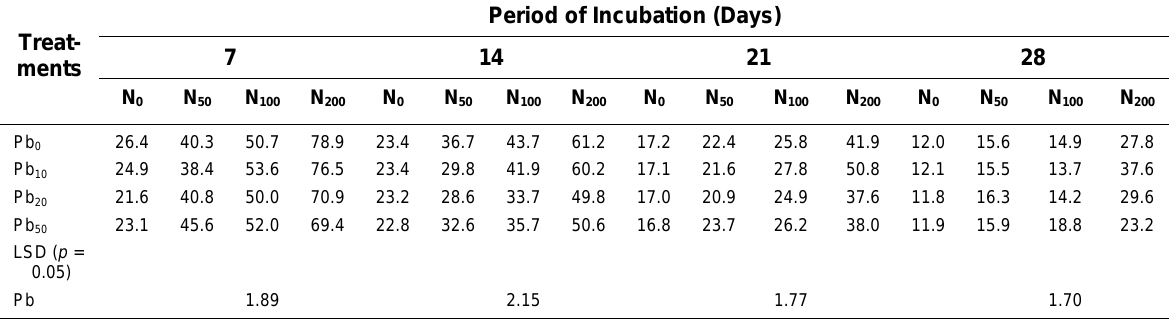
-N (mg kg –1 ) Content in Soil 4